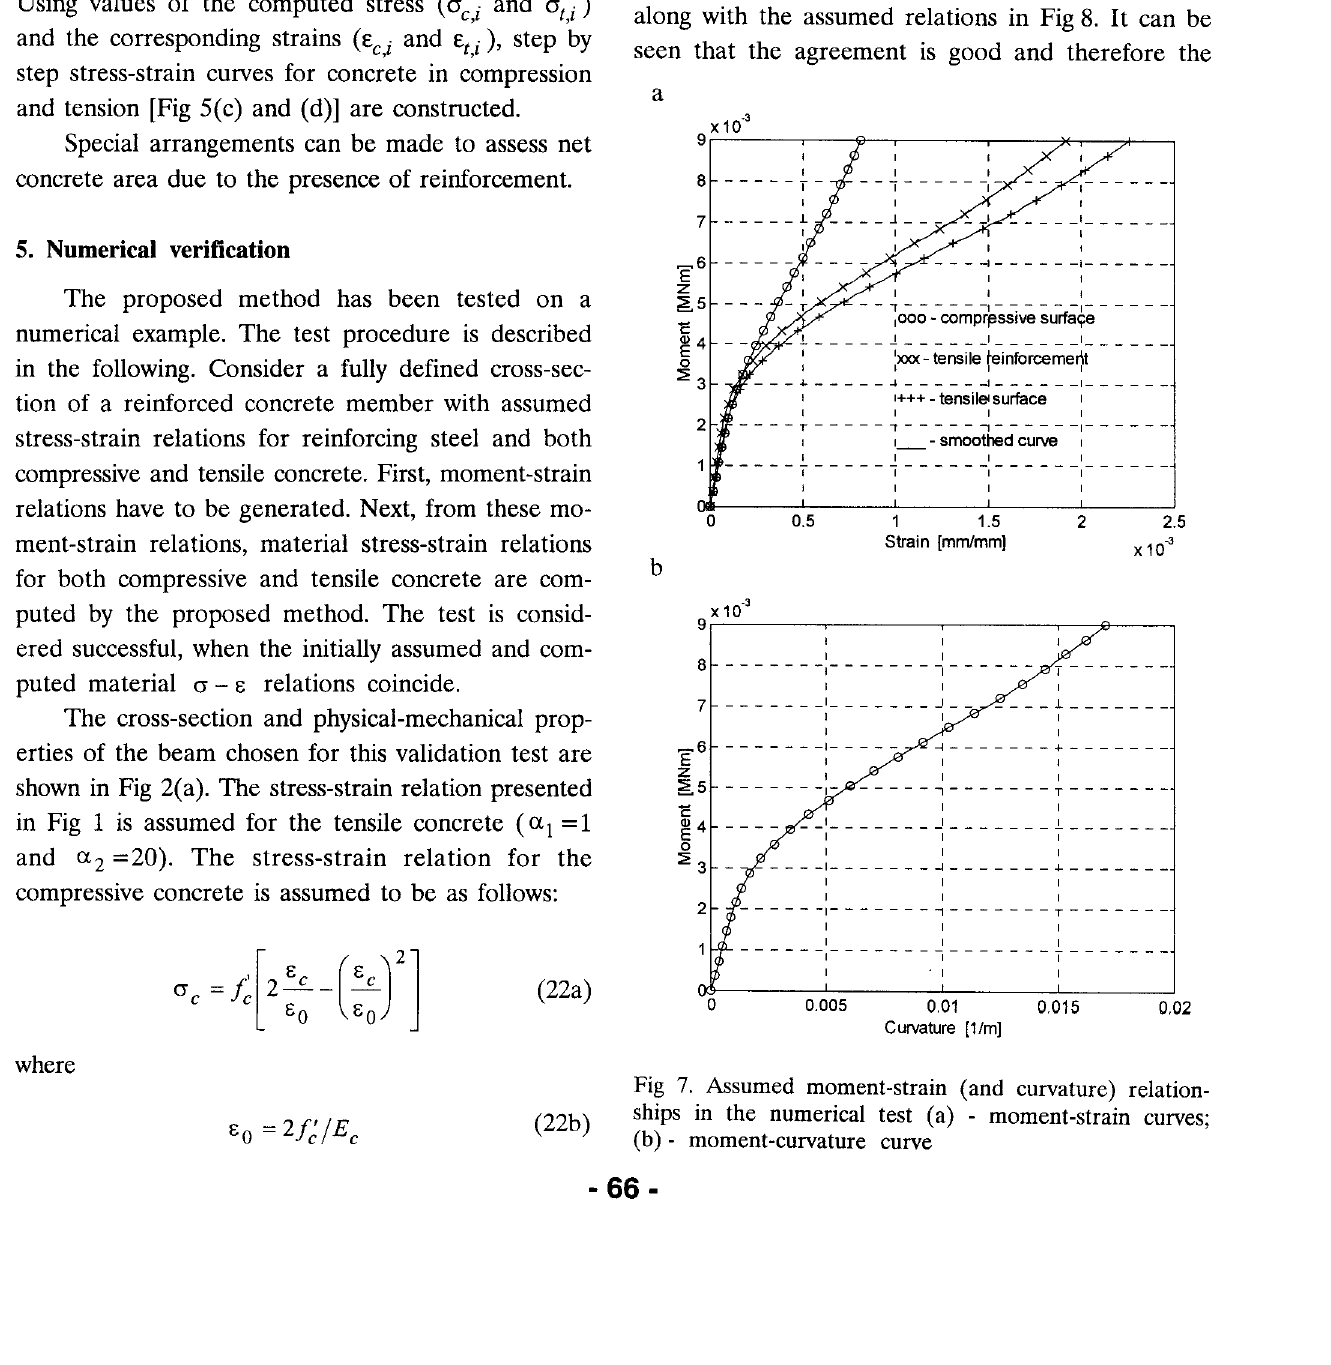
Fig 7. Assumed moment-strain (and curvature) relation- (22b) ships in the numerical test (a) - moment-strain curves; (b)- moment-curvature